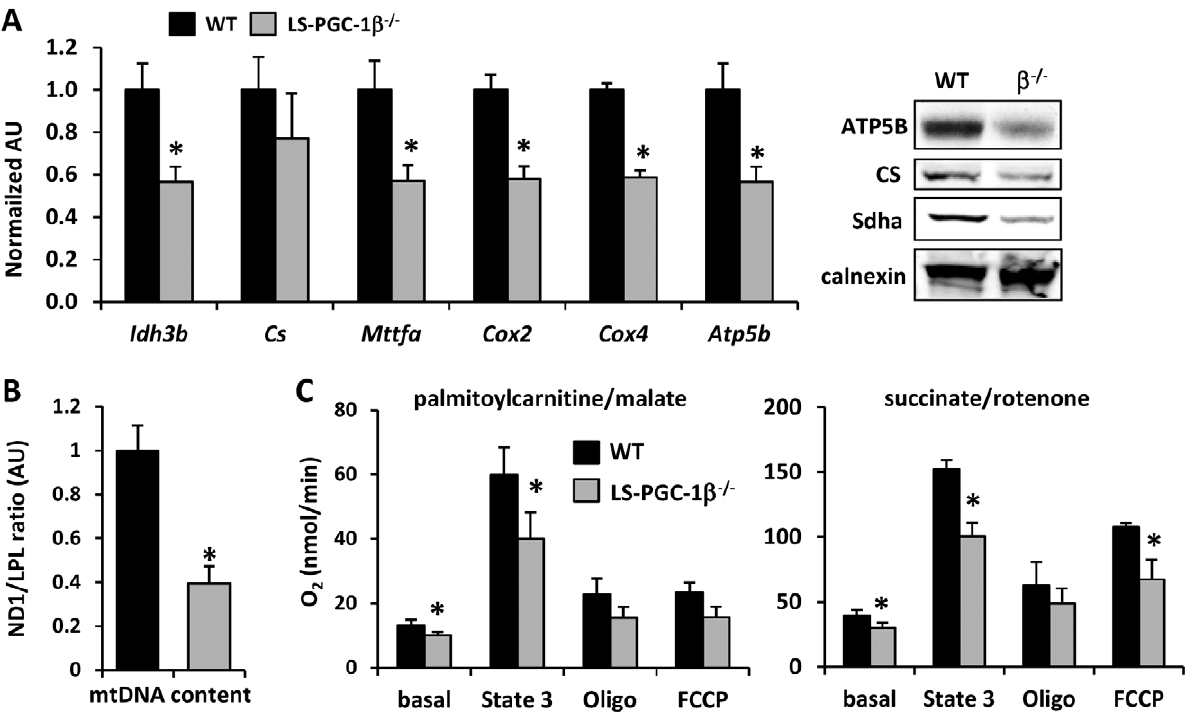
Figure 3. LS-PGC-1 b 2 / 2 mice exhibit decreased expression of TCA and ETC enzymes and mtDNA content. [ A ] The graph shows the expression of PGC-1 target genes involved in OXPHOS and TCA cycle in the liver of 6 week old female WT (fl/fl) or littermate LS-PGC-1 b 2 / 2 mice (n=5). *P , 0.05 vs. WT mice. Representative Western blot analysis using antibodies listed at left. [ B ] Mean hepatic mtDNA levels determined by real time PCR analysis shown as arbitrary units (AU; n=6/group). *P , 0.05 vs. WT mice. [ C ] Mitochondrial respiration was performed on isolated mitochondria from the livers of 6 week old WT (fl/fl) or littermate LS-PGC-1 b 2 / 2 mice (n=6) and substrates noted.*P , 0.05 versus WT mice.